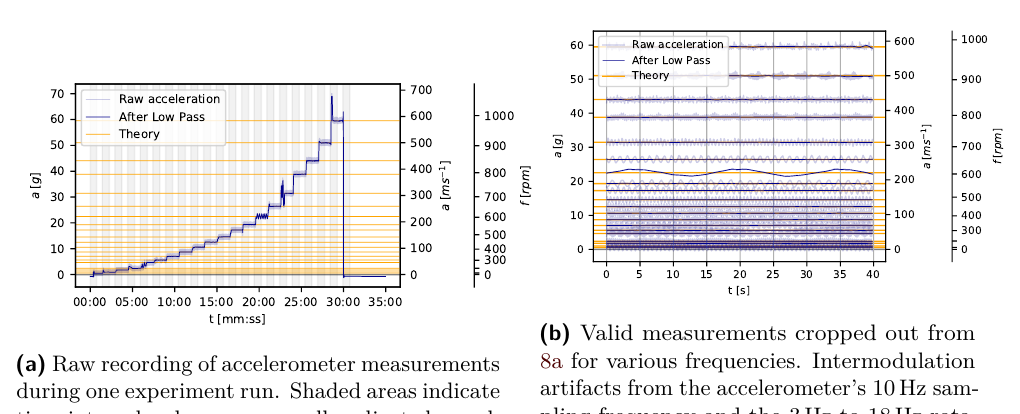
Figure 8: Traces of acceleration measurements during one experiment